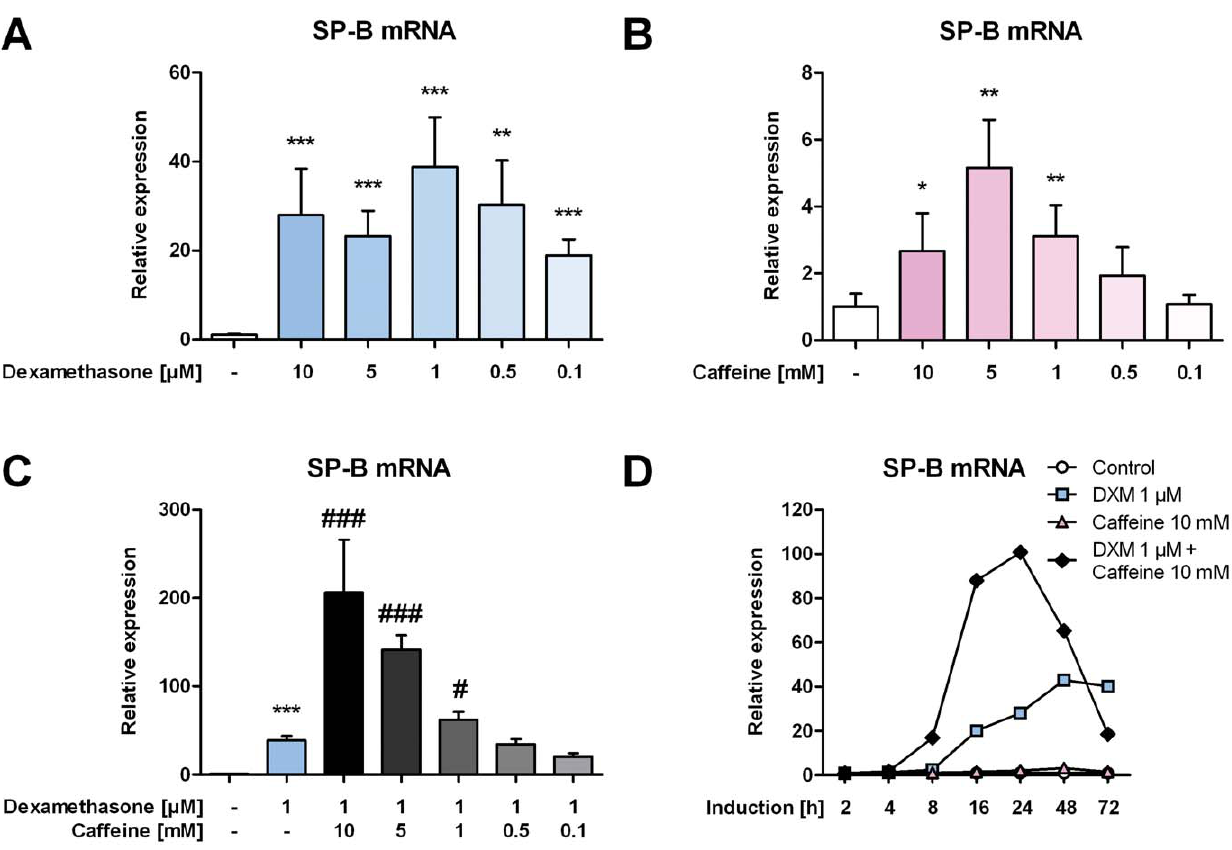
Figure 1. Synergistic effect of caffeine and dexamethasone on expression of SP-B mRNA in H441 cells. H441 cells were treated with different doses of dexamethasone (DXM) ( A ), caffeine ( B ), or combinations ( C – D ), and 24 h later( A – C ) or after various timepoints ( D ) qPCR of SP-B mRNA was performed. SP-B mRNA levels were normalized to b -actin, and fold differences compared to untreated cells were calculated. For A - C means 6 SD of at least n=3 independent experiments are shown. * p , 0.05, ** p , 0.01 and *** p , 0.001 compared to control cells, # p , 0.05 and ### p , 0.001 compared to cells treated with dexamethasone.